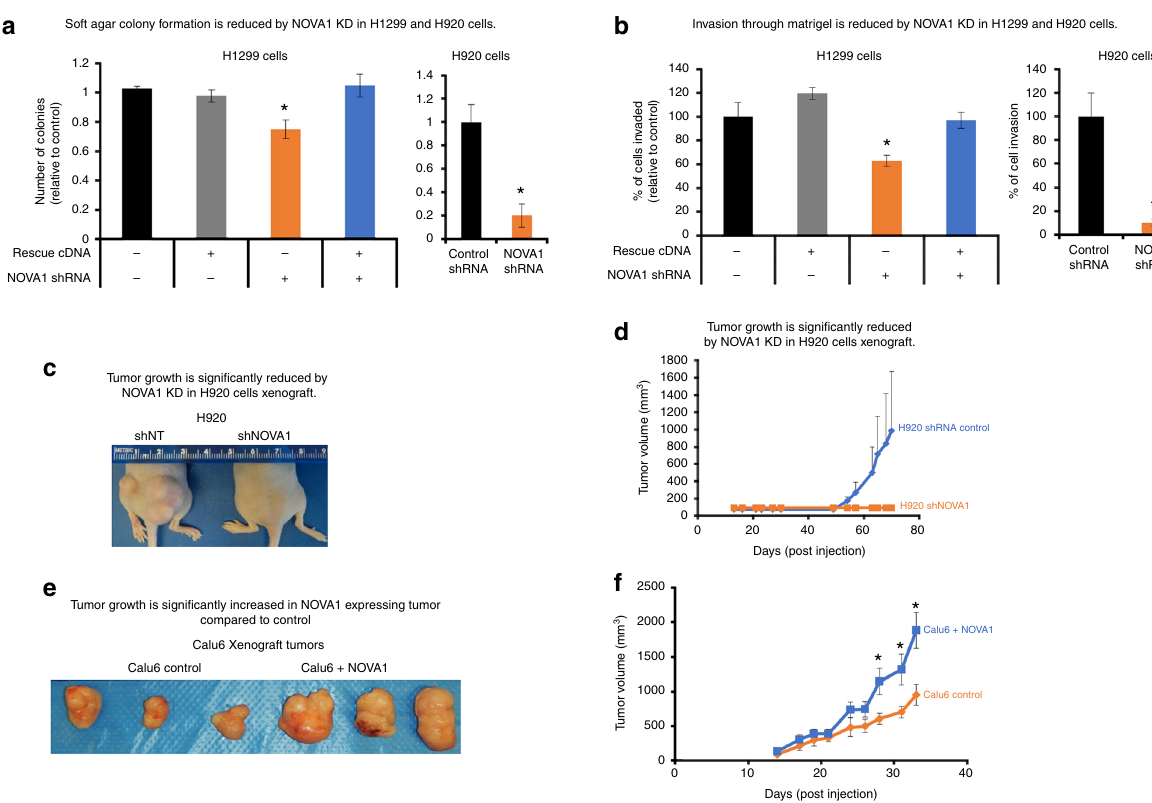
Fig. 3 Manipulation of NOVA1 in cancer cells alters xenograft tumor growth. a Knockdown of NOVA1 in H1299 and H920 cells reduced anchorage- independent cell growth compared to controls (soft agar colony formation assays, n = 3 for each condition and cell line). + indicates presence of shRNA or cDNA construct. − indicates absence of shRNA or cDNA construct. b Knockdown of NOVA1 in H1299 and H920 cells reduced migration through an extracellular matrix (Boyden Chamber assay) compared to controls ( n = 3 for each condition and cell line). + indicates presence of shRNA or cDNA construct. − indicates absence of shRNA or cDNA construct ( a , b ). c Knockdown of NOVA1 in H920 cells signi fi cantly reduced xenograft growth compared to controls. Left panel shows representative images of the hind quarters of nude mice. d Growth curves of xenograft tumors during the experiment ( n = 4 injections for each condition, 2 mice per condition). e Expression of NOVA1 in Calu6 cells results in larger xenograft tumors compared to Calu6 controls (a non-small cell lung cancer cell line lacking NOVA1 expression). Left panel shows representative images of tumors from Calu6 and Calu6 plus NOVA1 . Same stable cell line as used in Fig. 2 and Supplementary Figure 2. f Right panel shows growth curves of xenograft tumors during the experiment ( n = 6 injections for each condition, 3 mice per condition). Data are expressed as means and standard error of the mean where applicable. All tests shown are Student ’ s t test set at * p < 0.05 for signi fi cance. KD: knockdown. Note — an error bar on the controls of a – c was calculated by fi rst generating the mean of the controls and expressing each control relative to this value. We then calculated a standard deviation and standard error based on the variance observed between these normalized values. Supplementary data associated with this fi gure can be found in Supplementary Figure